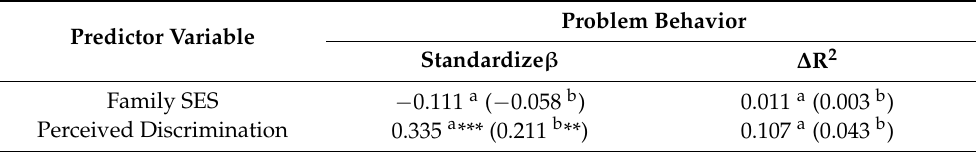
Table 4. Effects of family SES and perceived discrimination on problem behavior between left-behind and non-left-behind